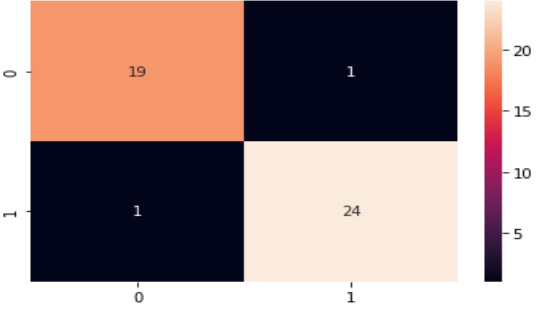
Figure 16. overall performance evaluation of the diseases.